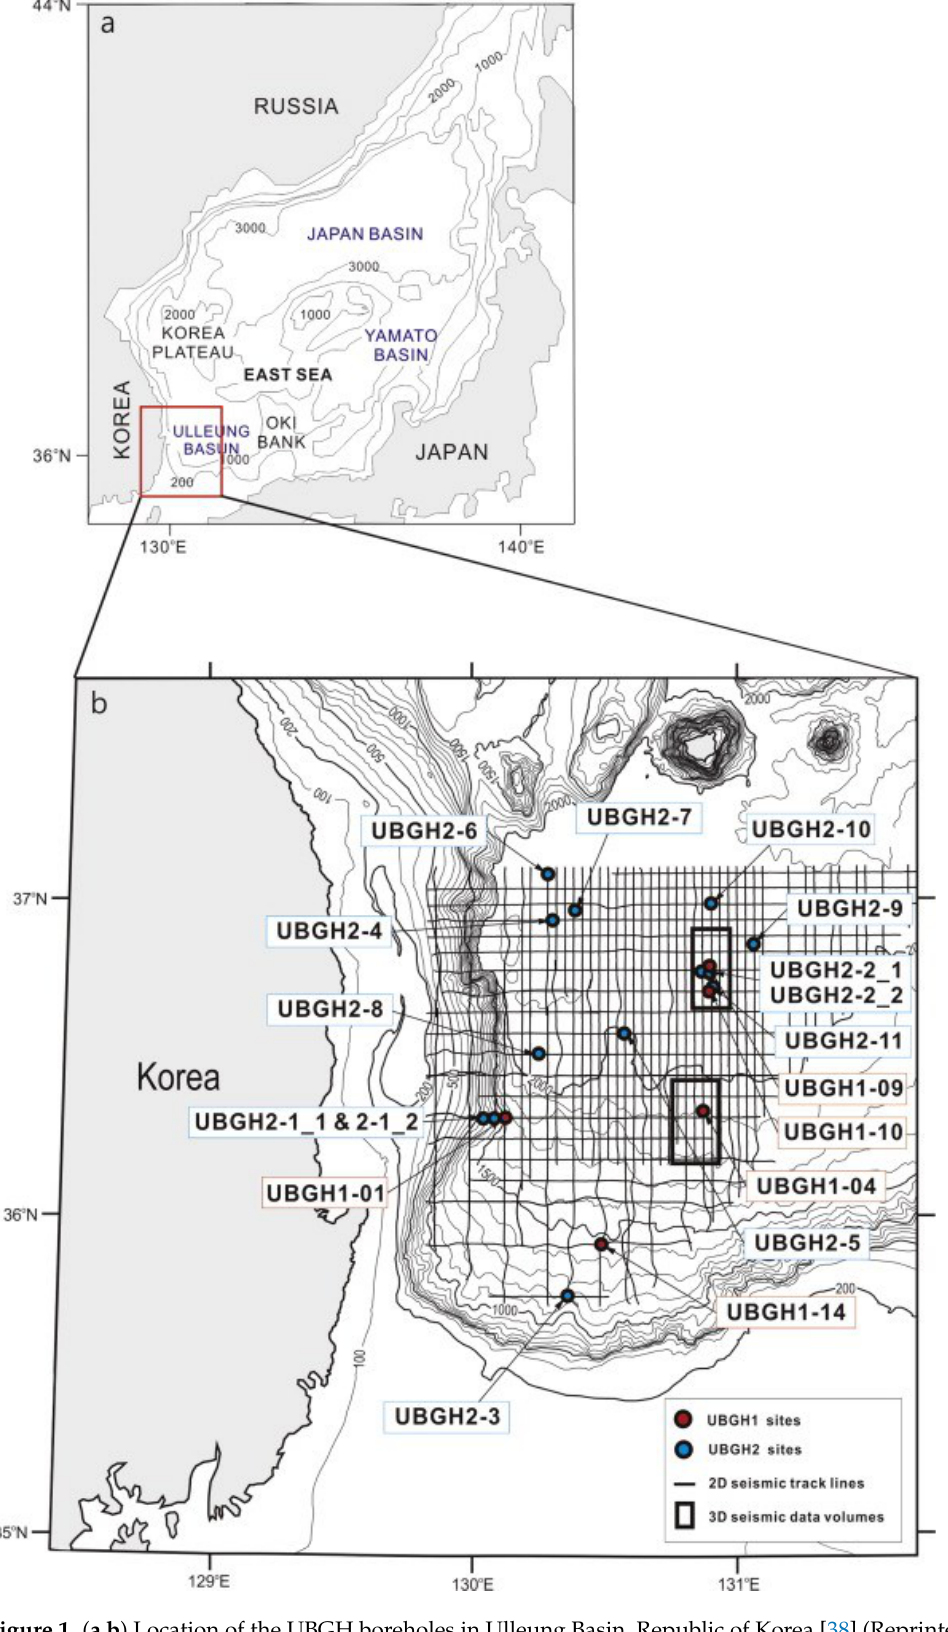
Figure 1. ( a , b ) Location of the UBGH boreholes in Ulleung Basin, Republic of Korea [38] (Reprinted with permission from Ref. [38]).